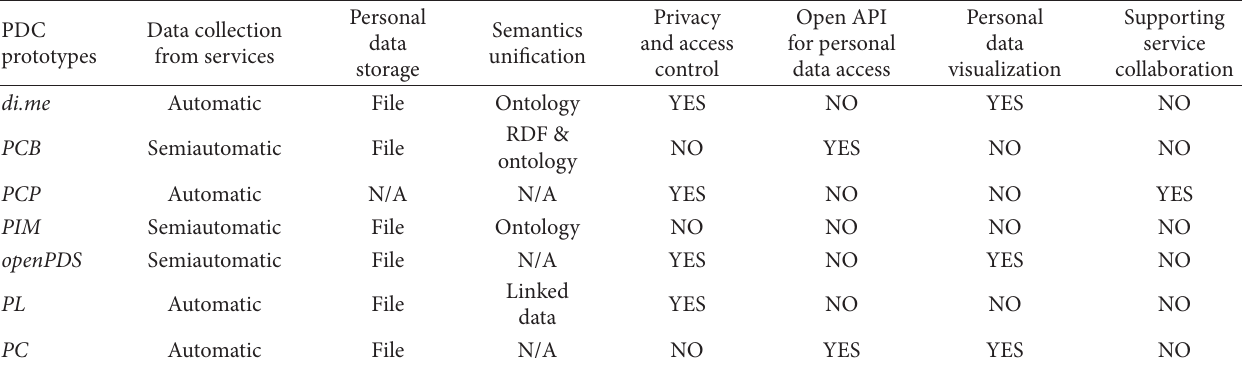
Table 2: Comparison between existing PDC